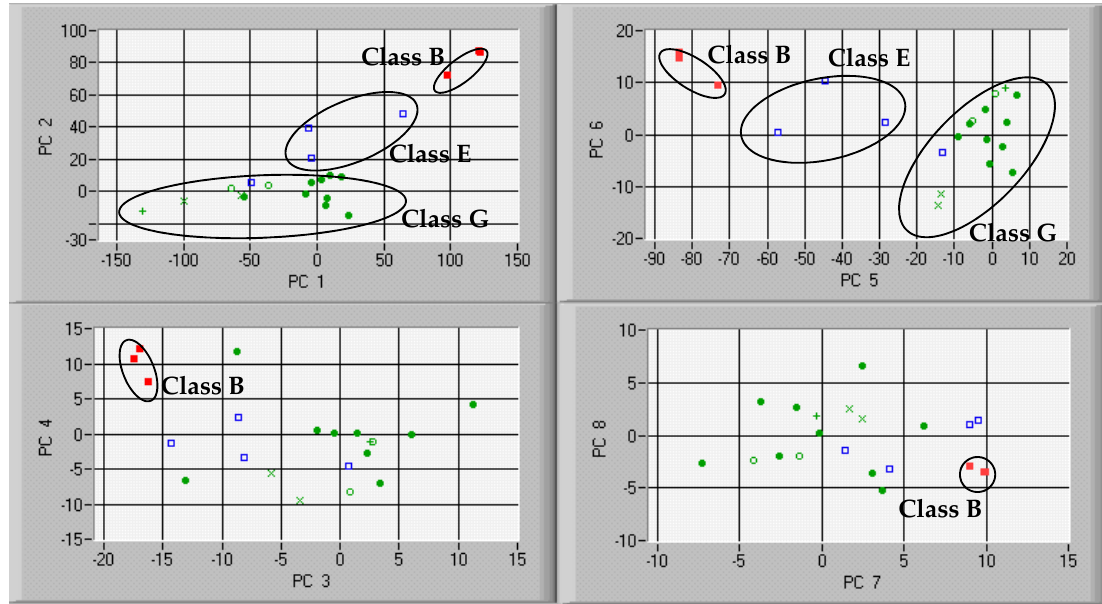
Figure 12. Representation of devices by PC1–PC8 for acquisition time equal to 15 min.